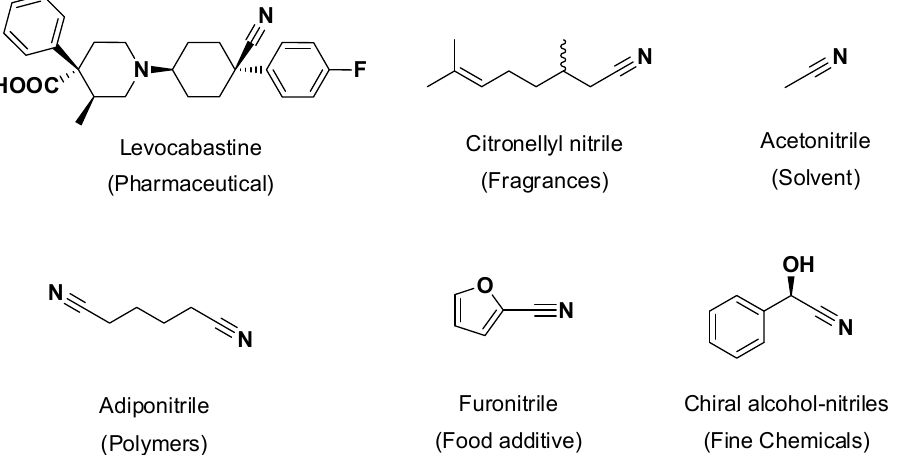
Figure 1. Selected examples of occurrence of nitriles with different uses as solvents, pharmaceuticals, food additives, or as polymer precursors